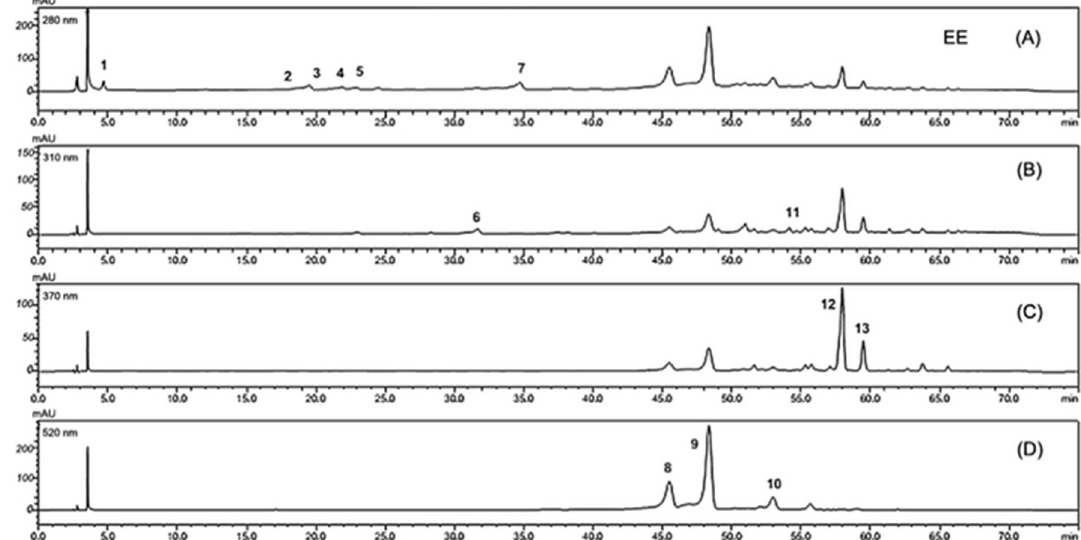
Figure 1. Chromatograph profile of tucum-do-cerrado peel extracts. (AqE) lyophilized aqueous extract; (EAF) lyophilized ethyl acetate fraction solubilized in water and methanol (9:1); (MAqF) lyophilized methanol/water fraction solubilized in water and methanol (9:1); (ME) methanol extract (1% HCl); (EE) ethanol extract (1.5 mol/L HCl). Chromatographic conditions: column C18; mobile phase deionized water:formic acid 9:1 ( v/v ); injection volume 20 µ L; and spectrophotometer detection at 280 nm ( A ); 310 nm ( B ); 370 nm ( C ) 520 nm ( D ).